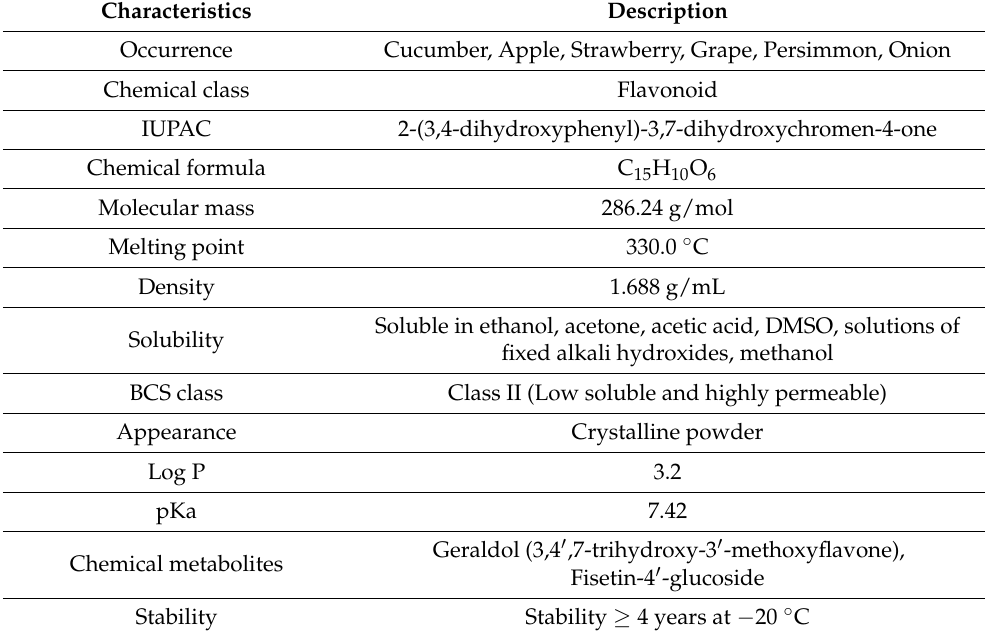
Table 1. Physicochemical properties of